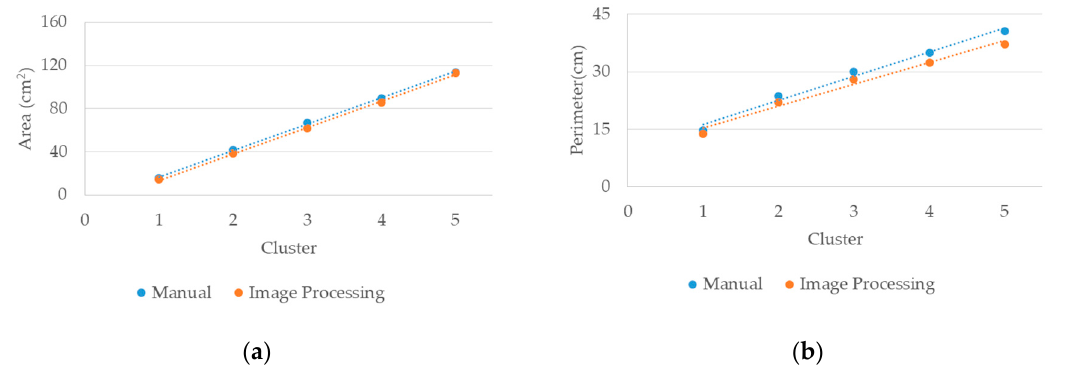
Table 5. Mean of area and perimeter for five grades.